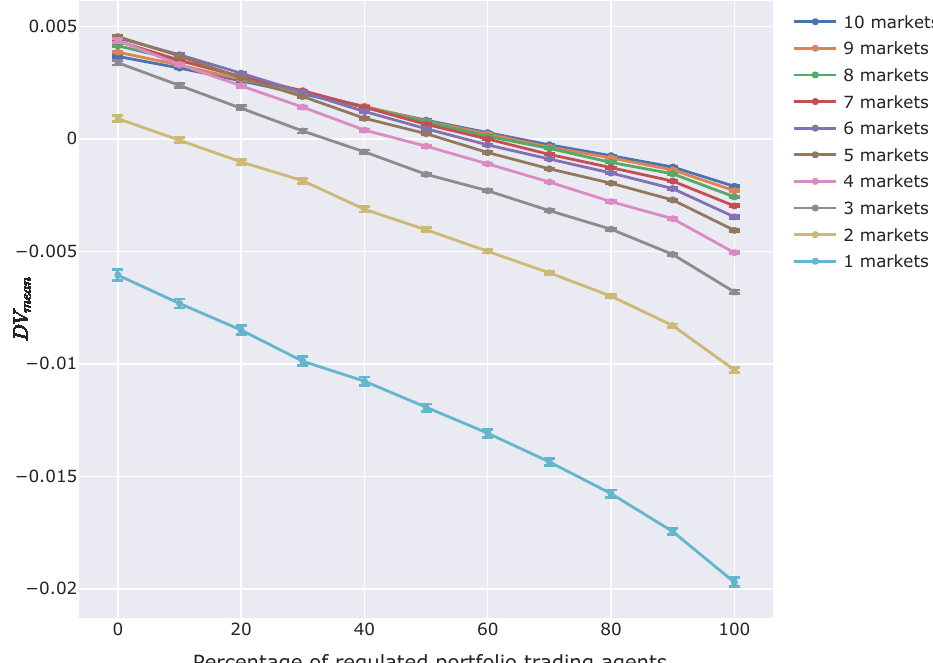
Figure 10. Mean DV in experiments for assessing the effect of CAR regulation. The horizontal axis is the percentage of regulated portfolio trading agents among all non-regulated and regulated portfolio trading agents. The vertical axis is the mean of DV t , which is defined in Equation (14). Each series of plots shows results for a certain number of markets in the simulation. Error bars show standard